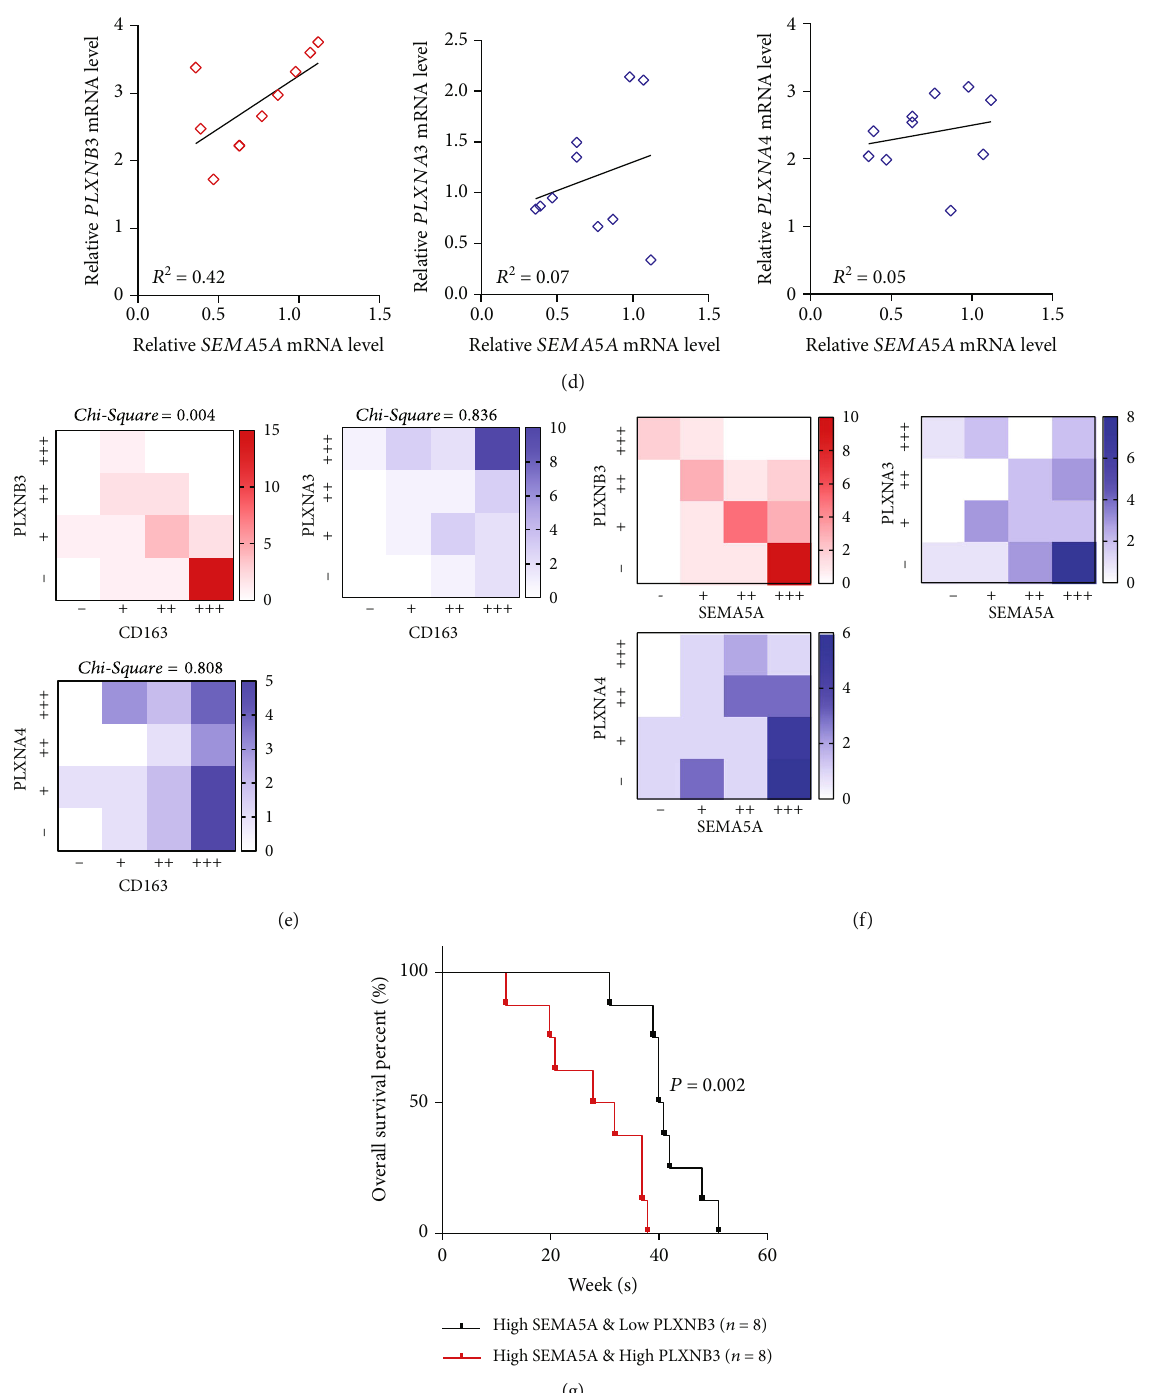
Figure 2: Aberrant dual high SEMA5A and PLXNB3 expressions lead to poor prognosis. (a) Real-time PCR measured expressions of PLXN family in TAMs slightly or severely in fi ltrated metastatic niches ( n = 5 samples per group). (b) IF staining on CK19 and PLXNA3 (top), PLXNA4 (middle), or PLXNB3 (bottom) in liver metastatic niches demonstrating PLXNs locations ( n = 20 patients, 3 fi elds assessed per sample). CK19, green; PLXNs, red; DAPI, blue; scale bars, 50 μ m. (c) IF staining on PLXNB3 and SEMA5A in liver metastatic niches displaying their colocation relationship ( n = 20 patients, 3 fi elds assessed per sample). PLXNB3, green; SEMA5A, red; DAPI, blue; scale bars, 50 μ m. (d) Relationships of PLXNB3 (left), PLXNA3 (middle), or PLXNA4 (right) mRNA expressions and SEMA5A were measured ( n = 10 samples). (e, f) Heat map showing the coexpression situations of PLXNB3, PLXNA3 or PLXNA4, and CD163 (e) or SEMA5A (f) in liver metastatic niches ( n = 30 ). (g) The Kaplan-Meier analysis on PDAC patients bearing dual high expressions of SEMA5A and PLXNB3 or single high expression of SEMA5A in liver metastatic niches ( n = 8 patients per